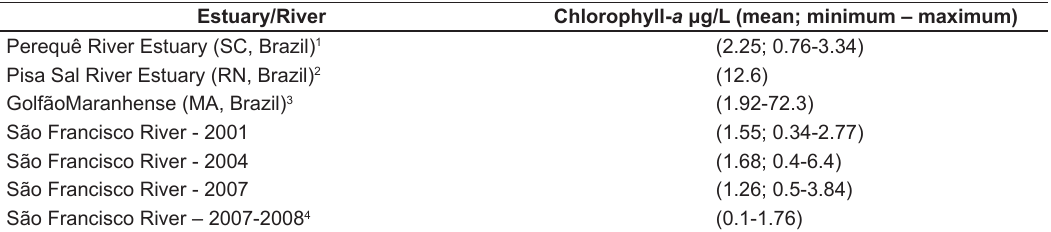
Table 6. Comparison on the values of chlorophyll-a from aquatic tropical Brazilian environments and from São Francisco